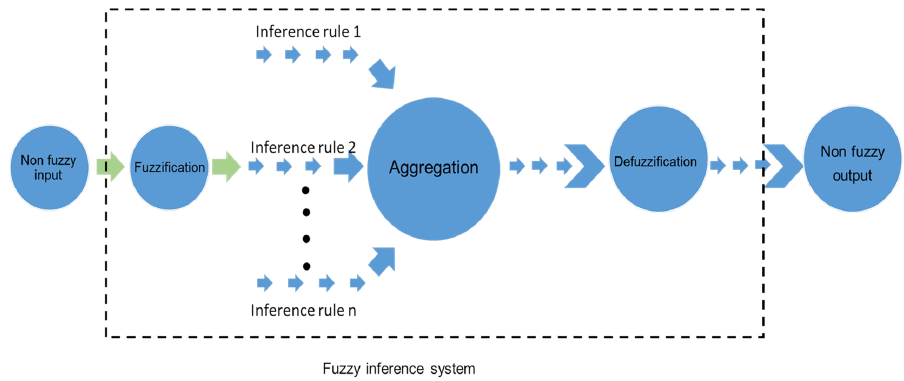
Figure 4. Fuzzy inference system.